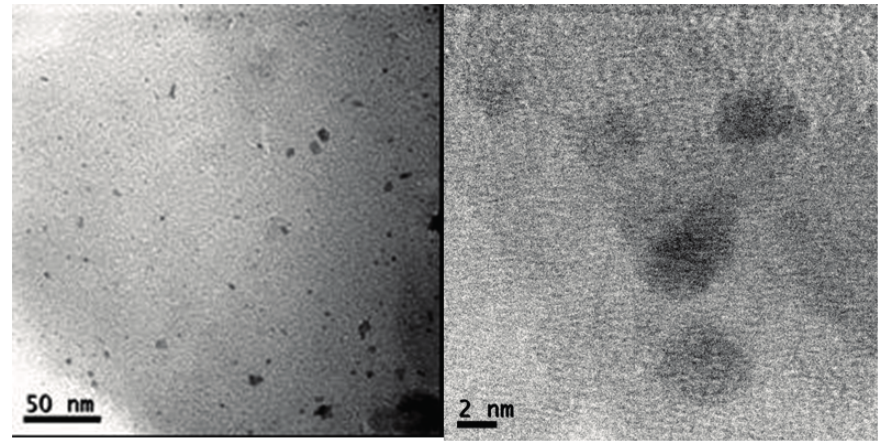
Figure 12. TEM images of Pd-pol subjected to the same reaction conditions reported in Table 3 using NaBH 4 but without